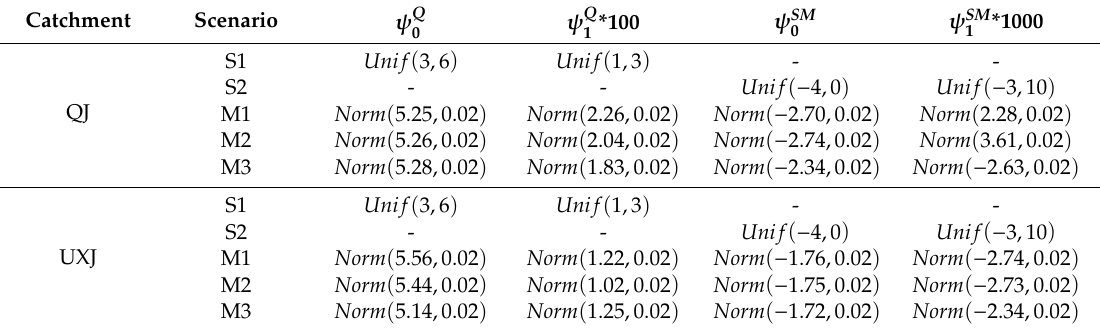
Table 3. Prior distributions of heteroscedastic residual error parameters ( ψ Q in various Bayesian scenarios (S1–S2, M1–M3) in either Qujiang (QJ) catchment and Upper Xijiang (UXJ)